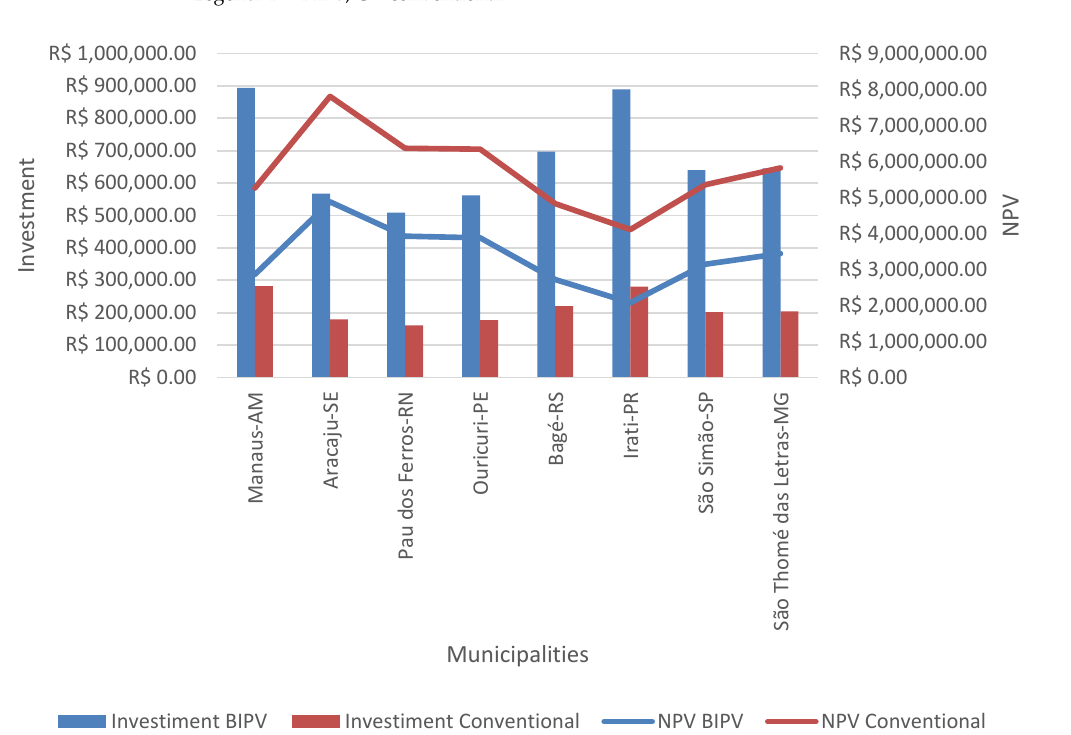
Figure 3. Representation of the results of the deterministic simulations for the studied locations. This dissimilarity between the values of investment in different cities has a direct relationship with their climatic particularities. The load and production of photovoltaic energy are affected by the local climate, including differences in air temperature and seasons [54]. The locations with the lowest investment values belong, respectively, to the and relatively short rainy periods